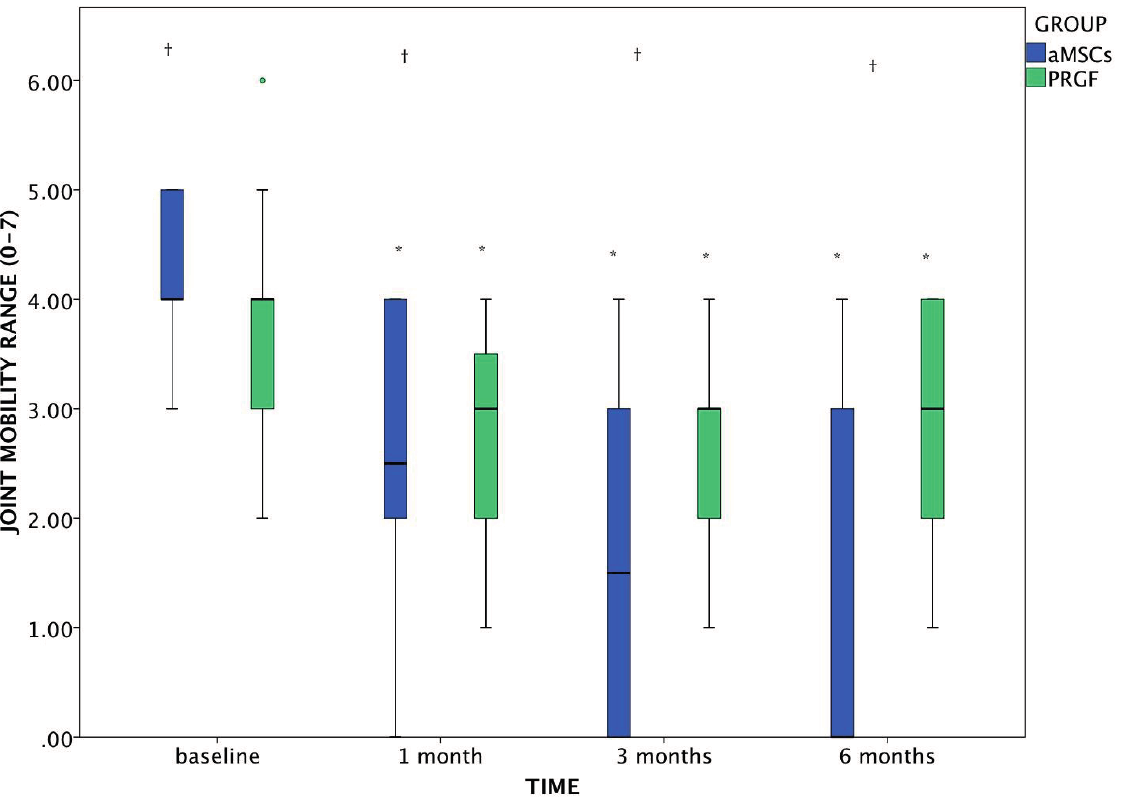
Figure 4. Evolution of joint mobility (range: 0–7) in dogs after aMSCs or PRGF treatment at the 6-months follow up period. The changes which differed significantly with baseline ( p < 0.05) are marked as * . Statistically significant differences between groups are marked as †. The green circle is an outlier included in the statistics